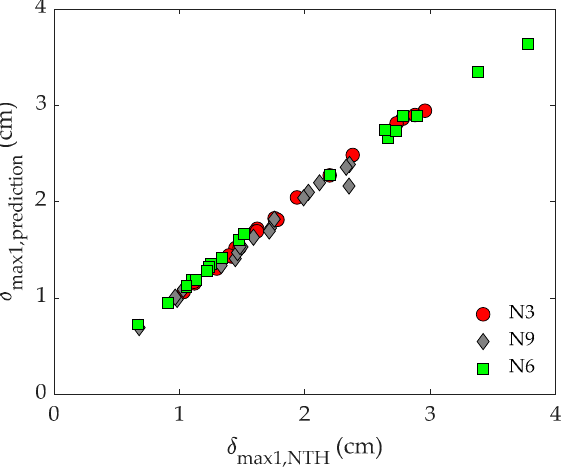
Figure 10. First-story drift predicted with Equation (19) using n eq,NTH ( δ max1,prediction ) and results from nonlinear time history analyses ( δ max1,NTH ).